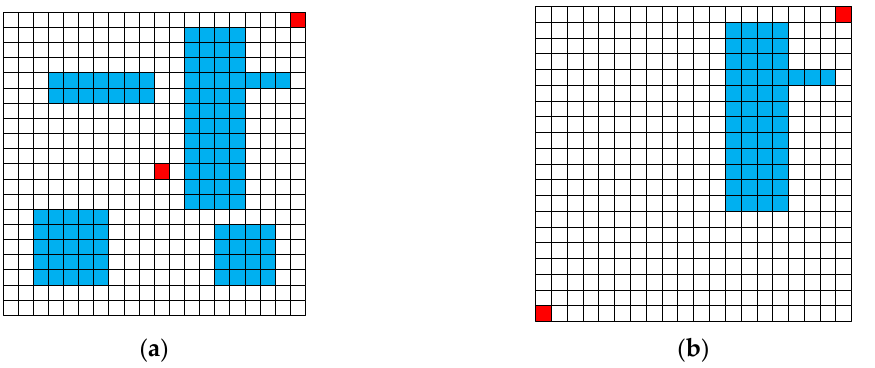
Figure 10. The experimental configuration of the 20 × 20 cells: ( a ) 20_4o; ( b ) 20_1o.